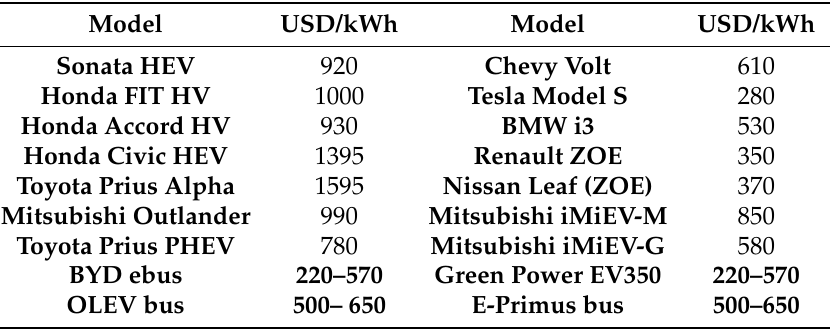
Table 4. Battery price [31–34]